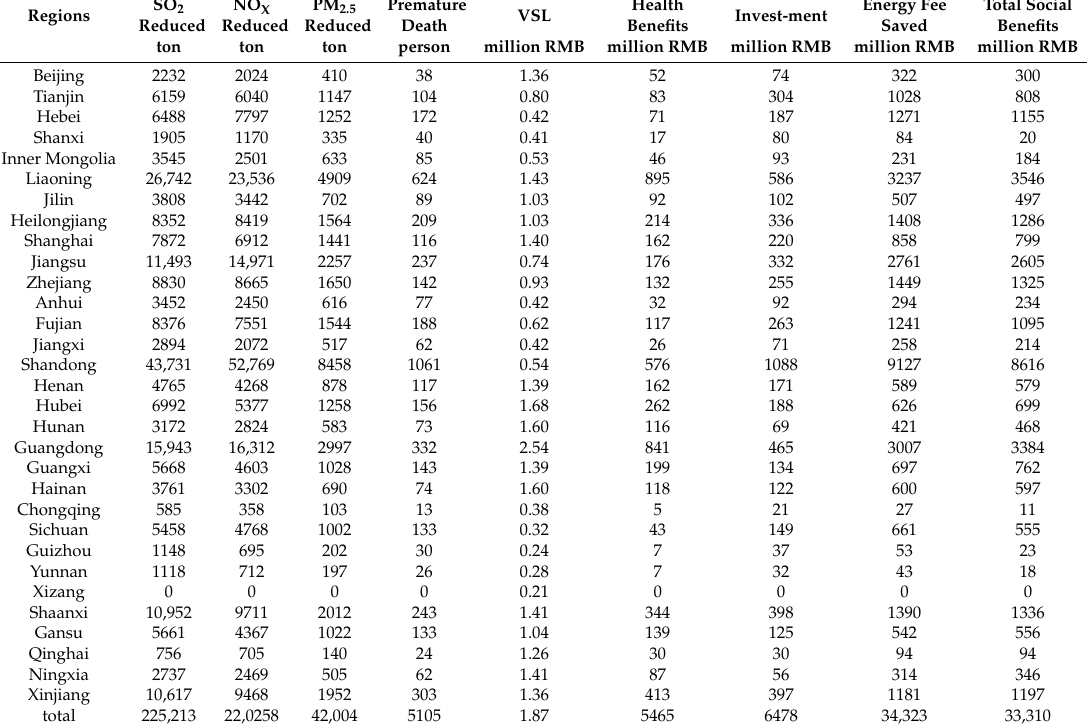
Table 7. Petrochemical industry provincial